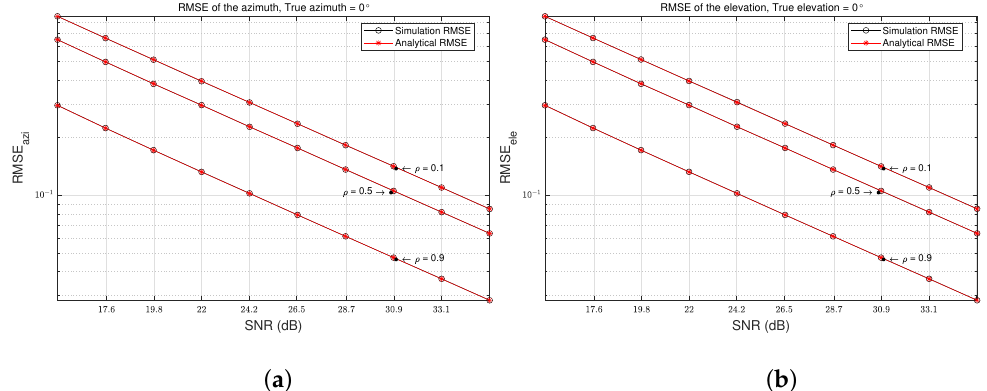
Figure 4. RMSE when the target and noise source are located on-axis (high SNR). ( a ) RMSE of ˆ θ azi . ( b ) RMSE of ˆ θ ele .